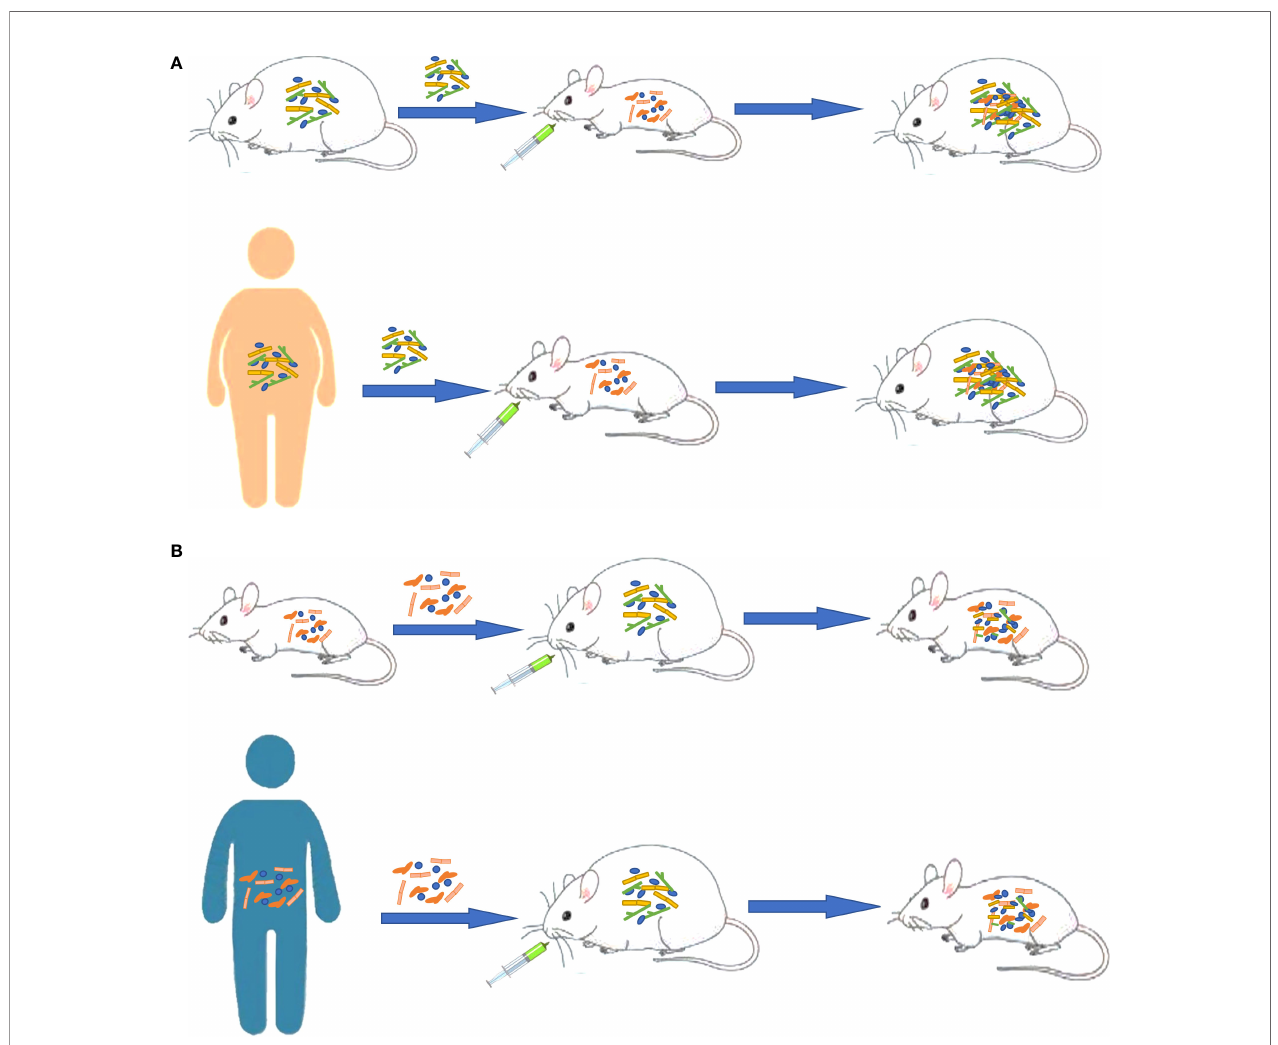
FIGURE 3 | Different functions of gut microbiota as a vector in obesity. (A) Transplanting the gut microbiota of sick animals/people into GF mice or normal mice can replicate the disease phenotype. (B) Transplanting normal gut microbiota into sick animals can have an effect on